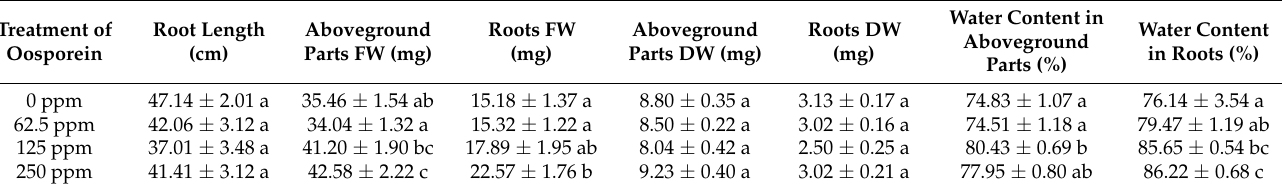
Table 3. Seedling growth of Oryza sativa in growth inhibition test by oosporein.